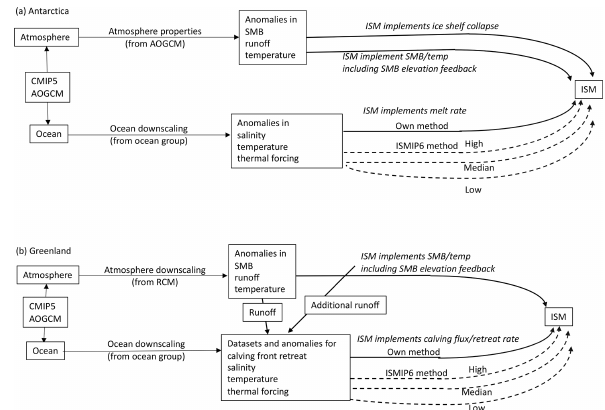
Figure 1. Overview of ISMIP6 (a) Antarctic and (b) Greenland projection framework, illustrating the strategy for translating the CMIP atmospheric and oceanic properties into climatic forcing for ice sheet